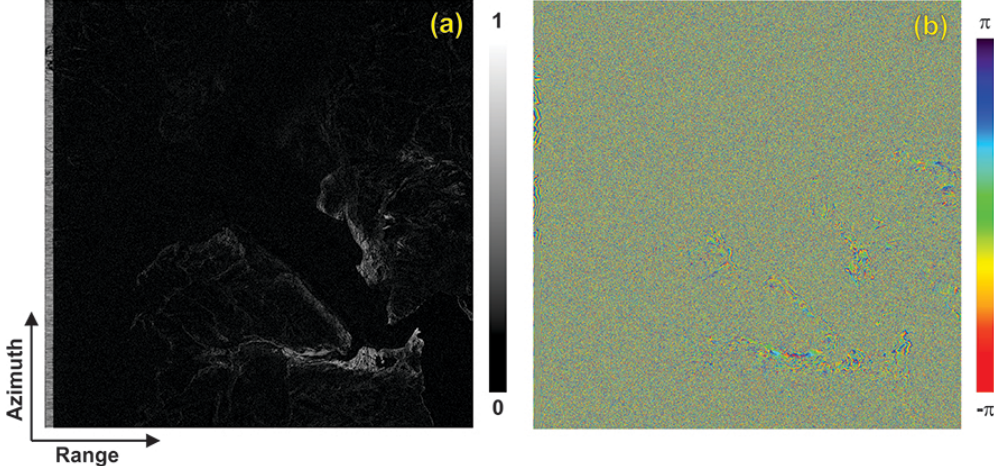
Fig. 2. Interferogram computed between scenes acquired on 31 May 2012 and 16 June 2012 (16 days timespan). (a) interferometric coher- ence. (b) wrapped interferogram. Loss of coherence is complete over the